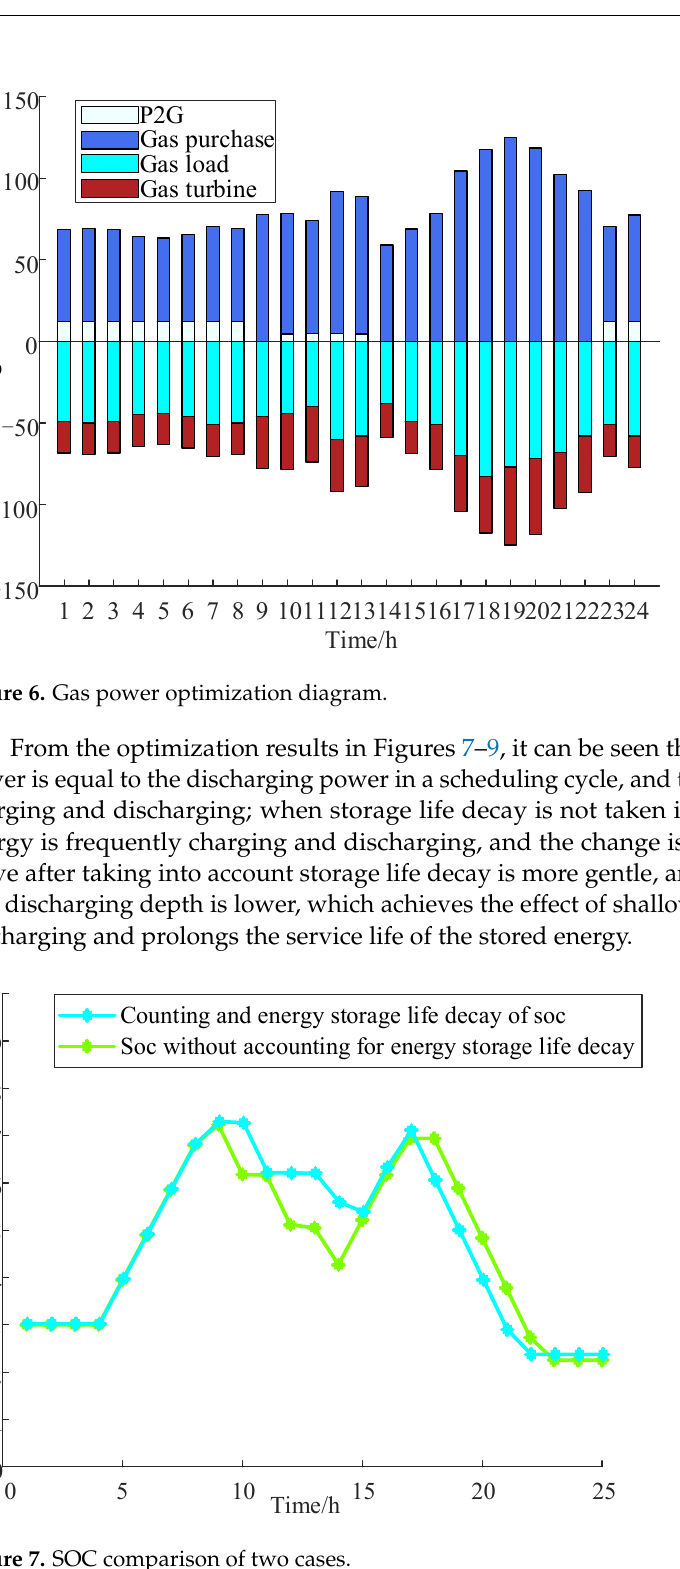
Figure 7. SOC comparison of two cases.